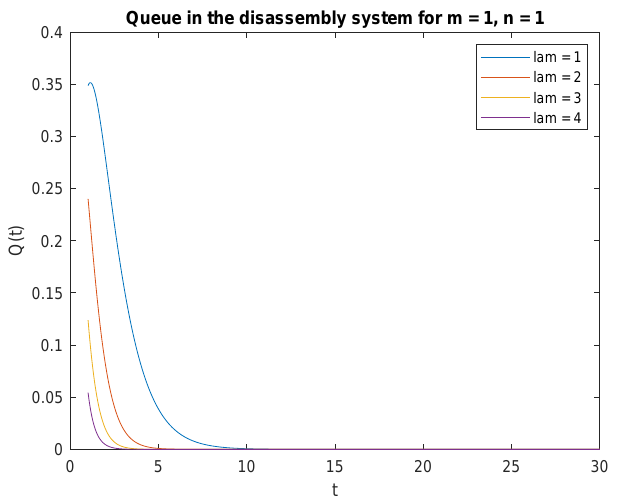
Figure 10. Impact of arrival rate on probability P { X ( t ) = 1 | X ( 0 ) = 0 } .